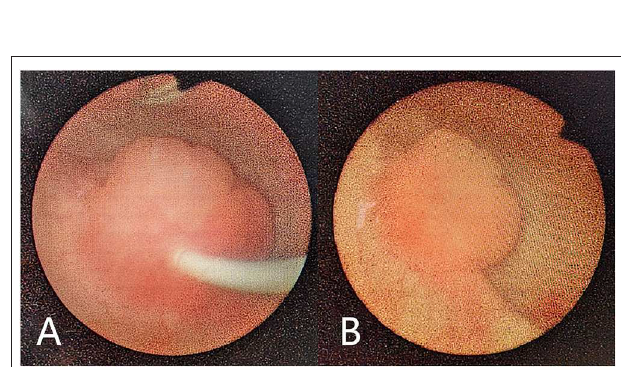
TABLE 2 | Comparison of operative details and outcomes between modified ureteral orthotopic reimplantation (OR) and Cohen reimplantation (CR). Operative details and outcomes OR ( n = 46) CR ( n = 43) p -value*